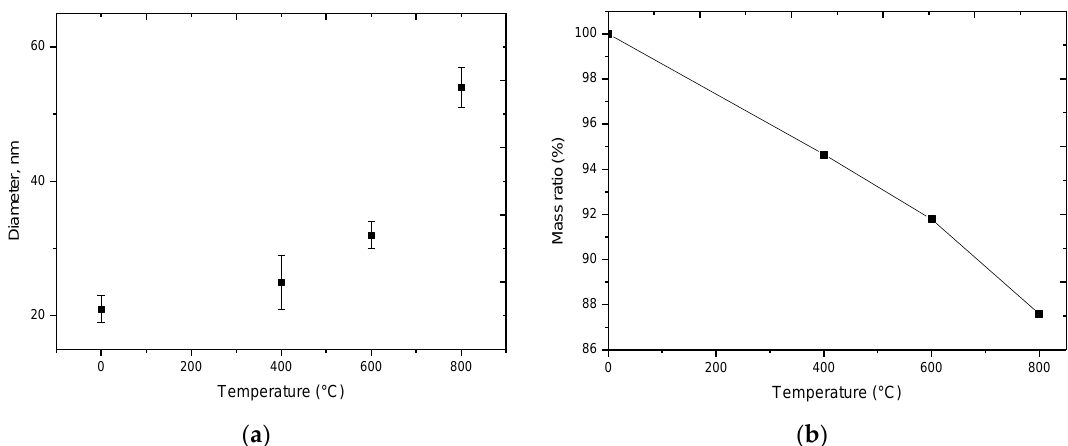
Figure 2. ( a ) Dynamics of change in the average size of nanoparticles; ( b ) results of thermo gravimetric analysis (TGA) change in mass of studied nanoparticles as a result of annealing.